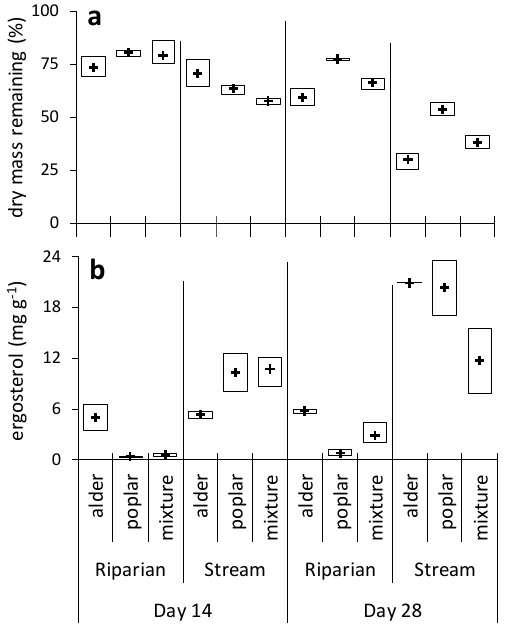
Figure 1. ( a ) Dry mass remaining and ( b ) ergosterol concentrations of leaves of alder, poplar 519 Figure 1. (a) Dry mass remaining and (b) ergosterol concentrations of leaves of alder, poplar and mixture decomposing in the stream and mixture decomposing in the stream and at the riparian zone of Ribeira do Botão. Values 520 and at the riparian zone of Ribeira do Botão. Values are ranges (boxes) and means ( + ) of n = are ranges (boxes) and means (  ) of n=3. 521